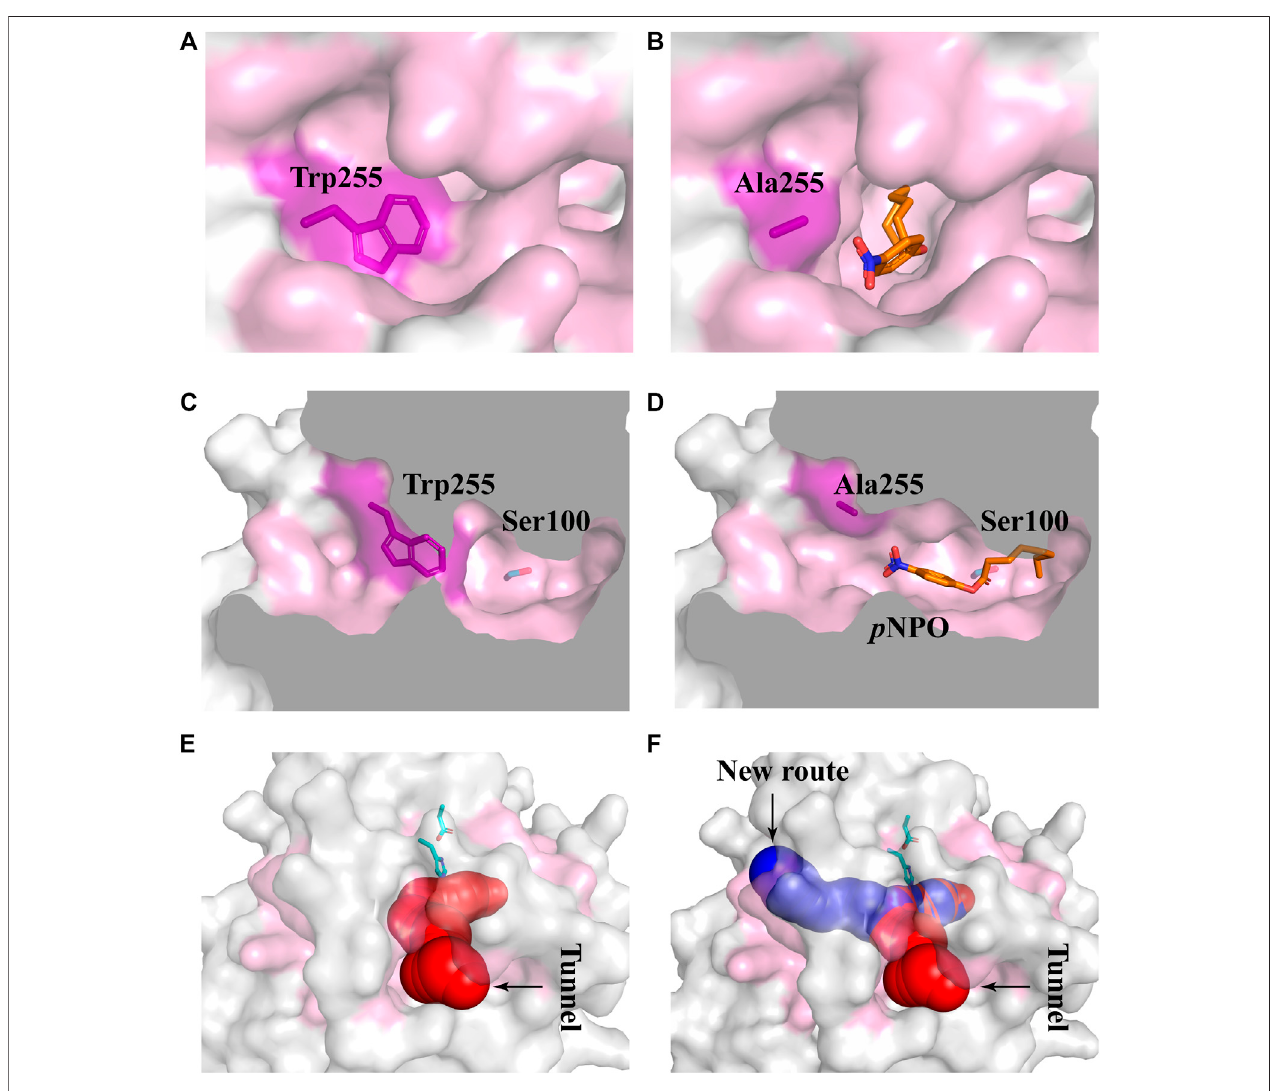
FIGURE7| Structuraldifferencesinthesubstrateaccesstunnelofwild-type Df FAEandW255Amutant. (A – B) TheentranceofthenewrouteofW255A (B) andthe main substrate access tunnel of WT (A) . (C – D) Cutaway view of the new route of W255A (D) and the main substrate access tunnel of WT (C) . (E – F) Comparison of the substrate access tunnel conformation of W255A (F) calculated by CAVER 3.0 and that of WT (E) . The binding pocket is colored by pink. The ligand p NPO is shown as orange stick, the new route and the main substrate access tunnel are shown as blue and red, respectively.